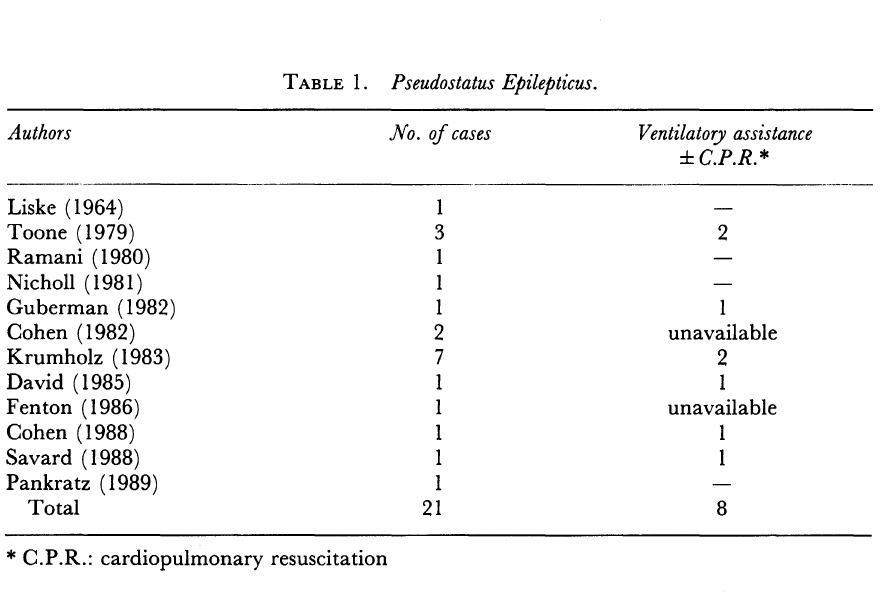
TABLE 1. Pseudostatus